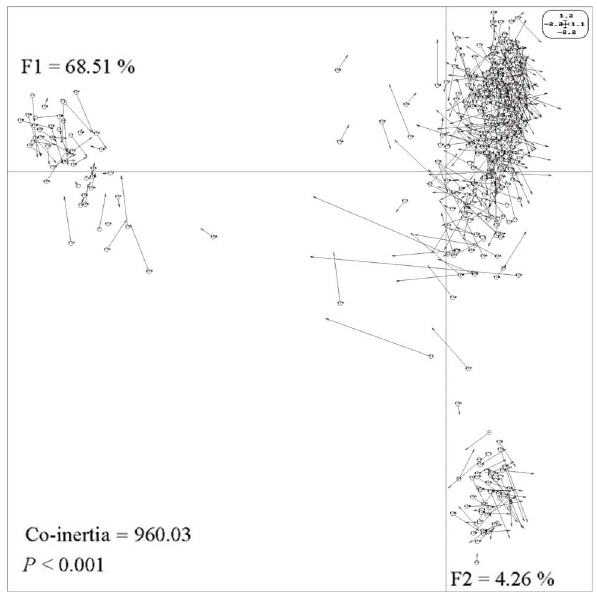
Figure 4. Co-inertia analysis of P . tomentosa using PCA scores on the basis of MSP and CG-CNG covariance matrices, which would be maximized. F1 and F2 values showed the contribution of the two principal components summarizing the total variance of each data set. The circles corresponded to the projection of the CG-CNG data profiles and arrows indicated the MSP data profiles. Numbers from 1 to 432 represent populations of: Beijing (1–20), Hebei (21–134), Shandong (135–153), Henan (154–267), Shanxi (268–347), Shaanxi (348–411), Gansu (412–417), Anhui (418–427), and Jiangsu (428–432). The significance was tested with 9999 Romesburg randomization permu- tations.